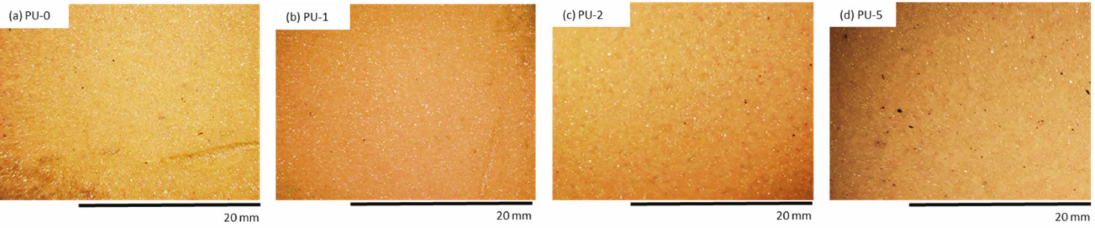
Figure 13. The external surface of ( a ) PU-0, ( b ) PU-1, ( c ) PU-2, ( d ) PU-5 after 7 days of UV aging.